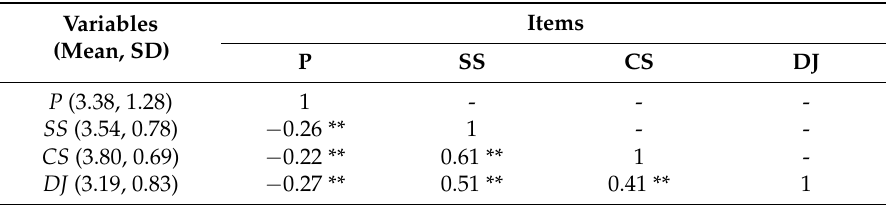
Table 2. Intercorrelations between presenteeism (P), supervisor support (SS), coworker support (CS) and distributive justice (DJ)